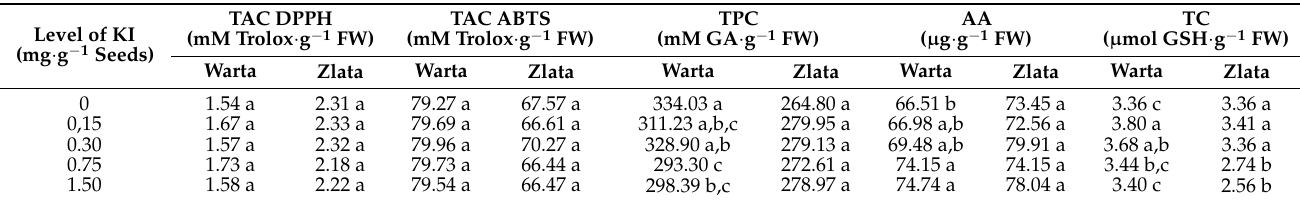
Table 4. Content of antioxidant substances in radish seedlings biofortified with iodine. Level of KI (mg · g − 1